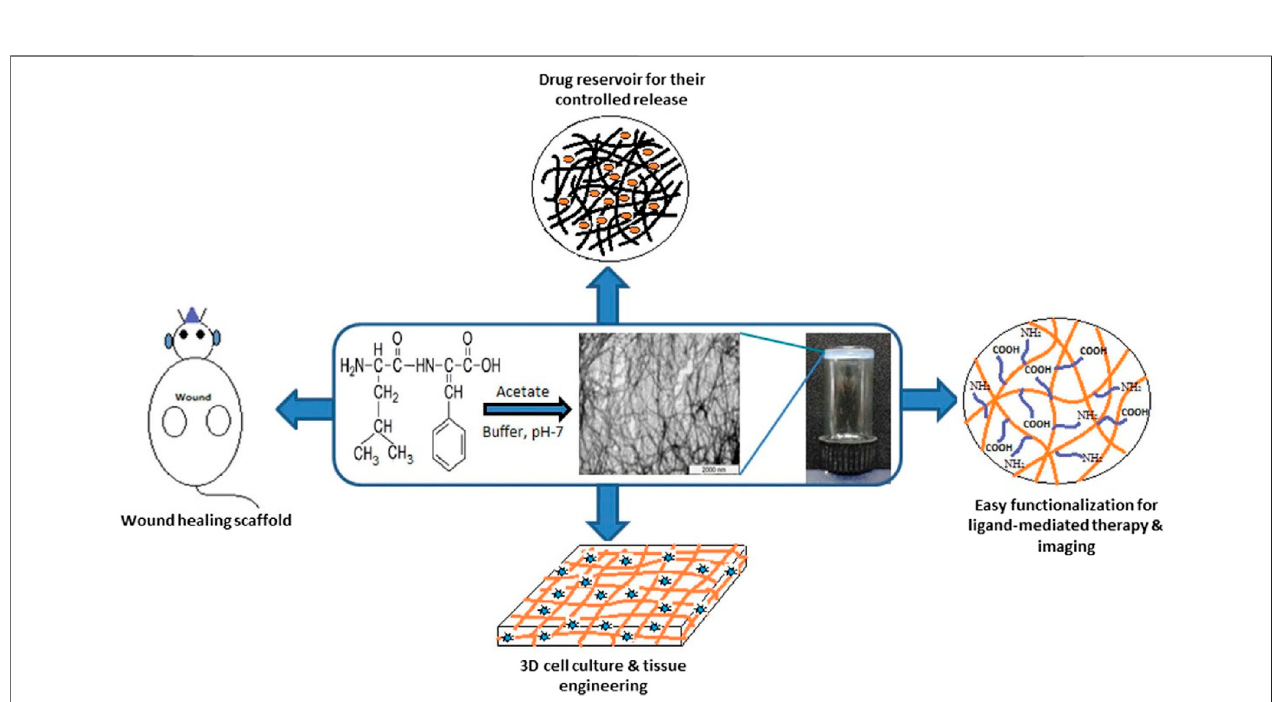
FIGURE 11 | Leu Δ Phe can be self-assembled into a stable hydrogel at room temperature and applied in the biomedical fi eld (Thota et al., 2016).